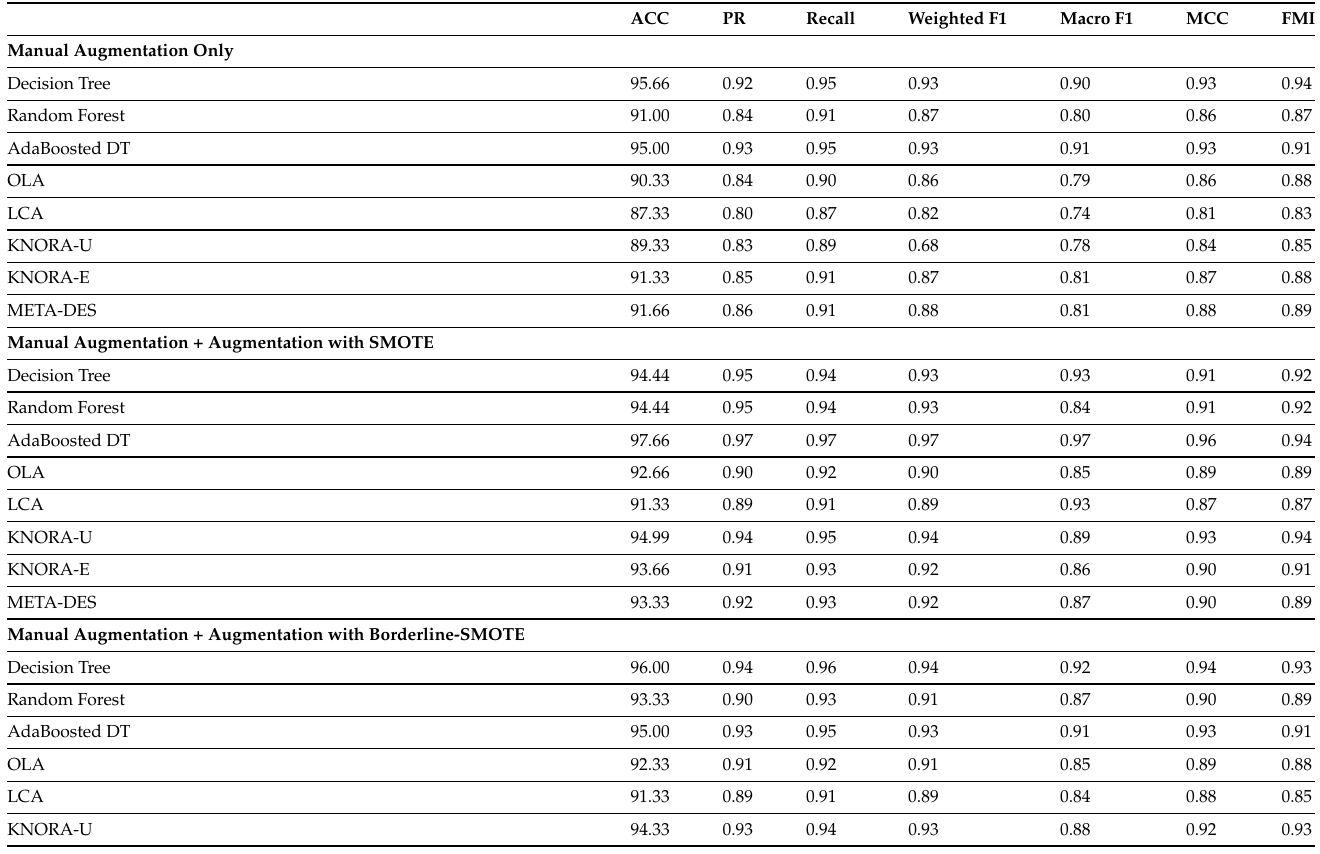
Table 5. Results for the multiple stratified CV method for the ensemble models implemented based on the framework proposed by Pineda-Bautista et al.